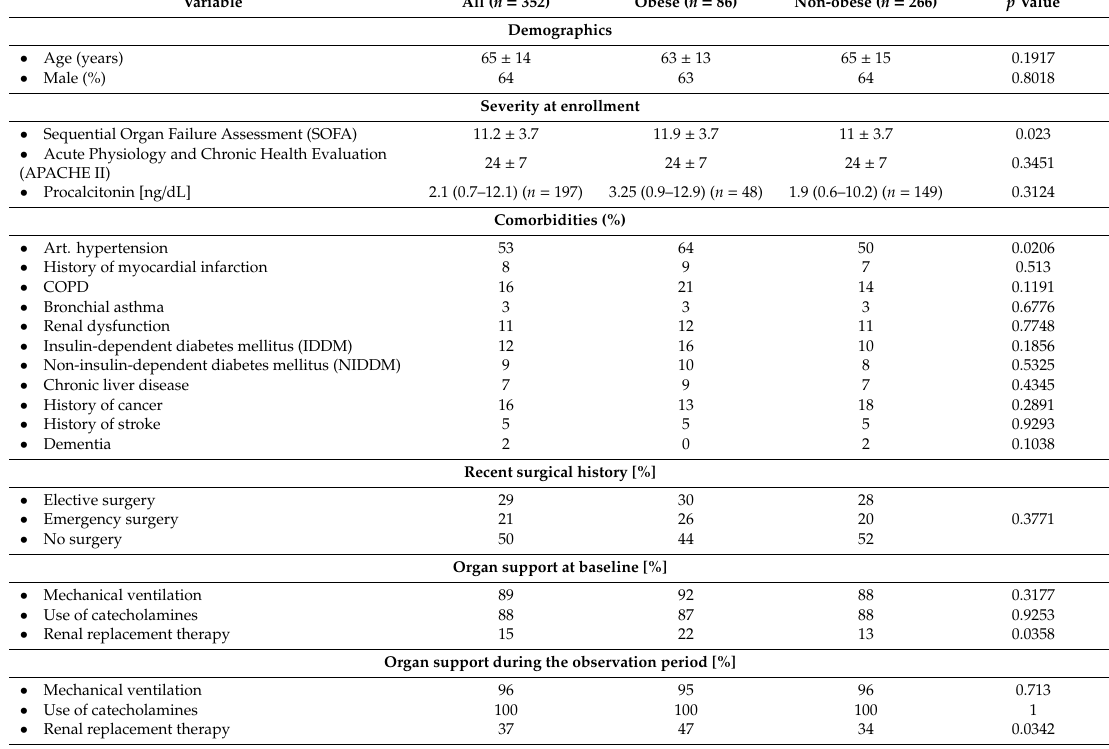
Table 1. Patient baseline characteristics with respect to obesity